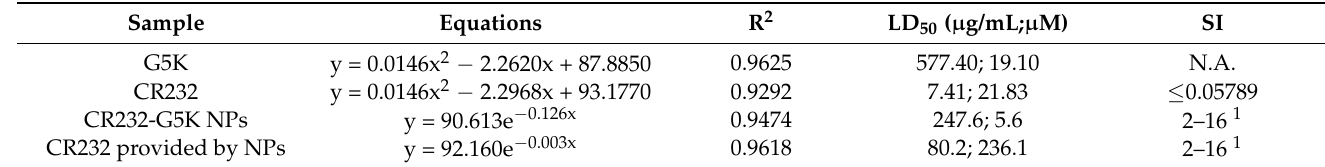
Table 6. Regression equations, R 2 values, LD 50 of G5K, CR232, CR232-G5K NPs, and of the nano- engineered CR232 provided by NPs according to the LD 50 determined for CR232-G5K NPs (24 h treatments), as well as the relative SI ranges calculated using Equation